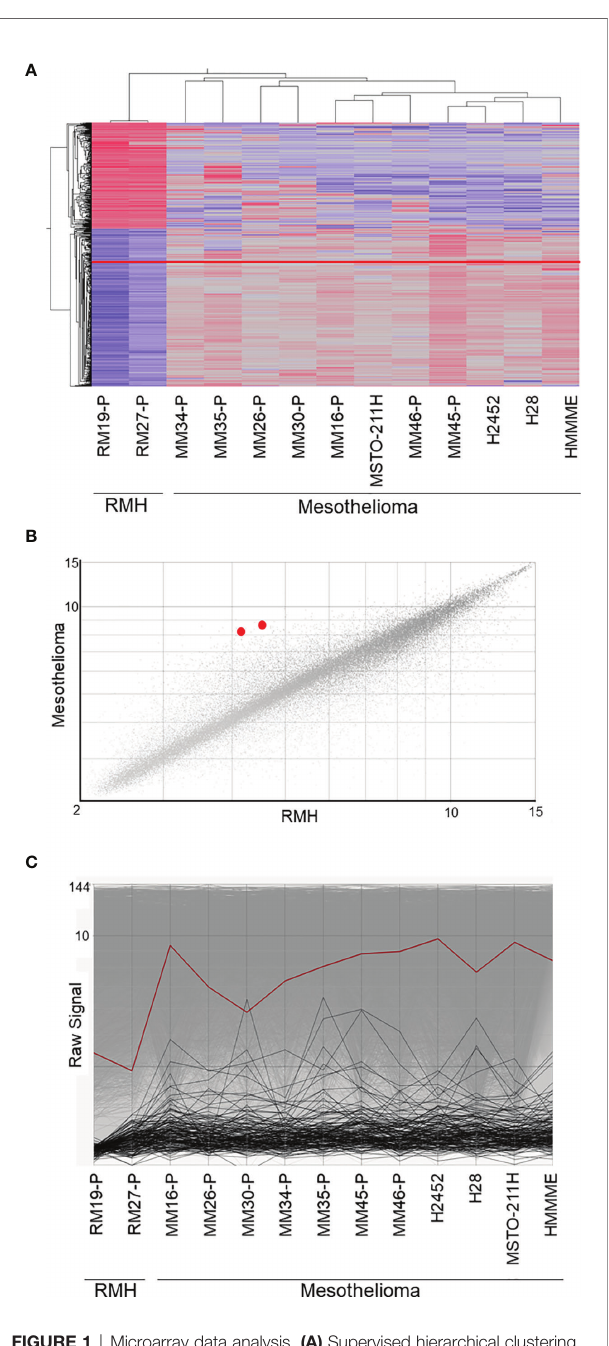
FIGURE 1 | Microarray data analysis. (A) Supervised hierarchical clustering of 11 malignant mesothelioma samples and 2 reactive mesothelial hyperplasia samples. IGF2BP3, presented as a red line, is upregulated in malignant mesothelioma, as compared with its expression in reactive mesothelioma hyperplasia. (B) The scatter plot showing the correlation between gene expression in malignant mesothelioma and reactive mesothelial hyperplasia. The two IGF2BP3 transcripts, shown as red dots, were upregulated in malignant mesothelioma when compared against expression in reactive mesothelial hyperplasia. (C) Line graph showing the gene expression in malignant mesothelioma and reactive mesothelial hyperplasia; IGF2BP3 expression, represented by the red line, is higher in malignant mesothelioma than in reactive mesothelial hyperplasia. RMH, reactive mesothelial